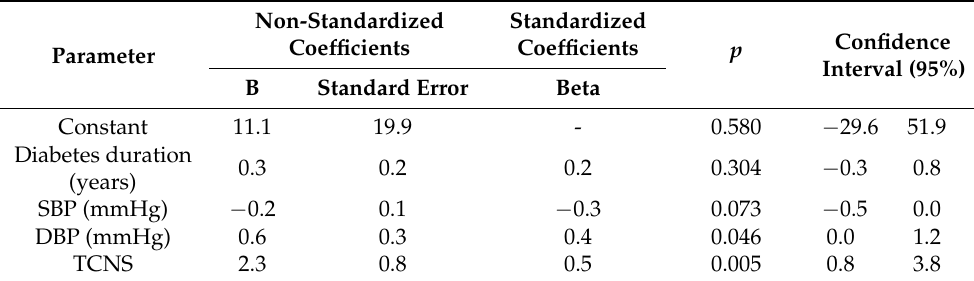
Figure 4. TCNS in patients found at high and low or no risk for CAN. Abbreviations: CAN—cardiac autonomic neuropathy, TCNS—Toronto Clinical Neuropathy Score. In the multiple linear regression analysis (SUDOSCAN CAN risk-score-dependent variable; diabetes duration, SBP, DBP and TCNS-independent variables), the SUDOSCAN CAN risk score was independently associated with higher DBP and higher TCNS (Table 3). Table 3. Multiple linear regression analysis (SUDOSCAN CAN risk-score-dependent variable; dia- betes duration, SBP, DBP and TCNS-independent variables).